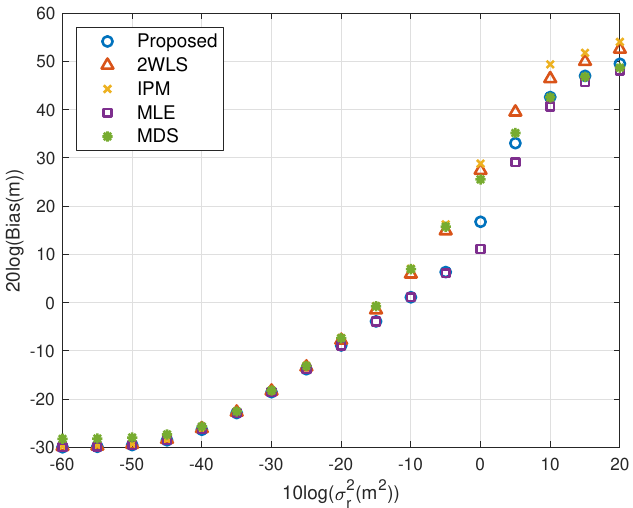
Figure 2. MSE performance as noise power increasing (near source, 4 sensors).